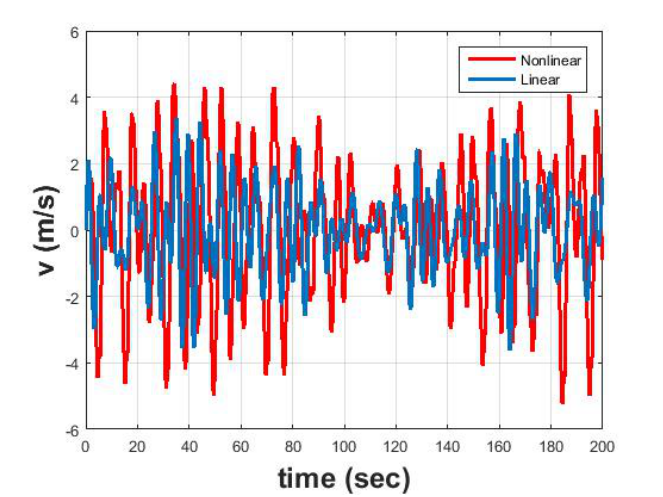
Figure 19. Comparison between the linear and nonlinear WECs in irregular waves: buoy velocity.